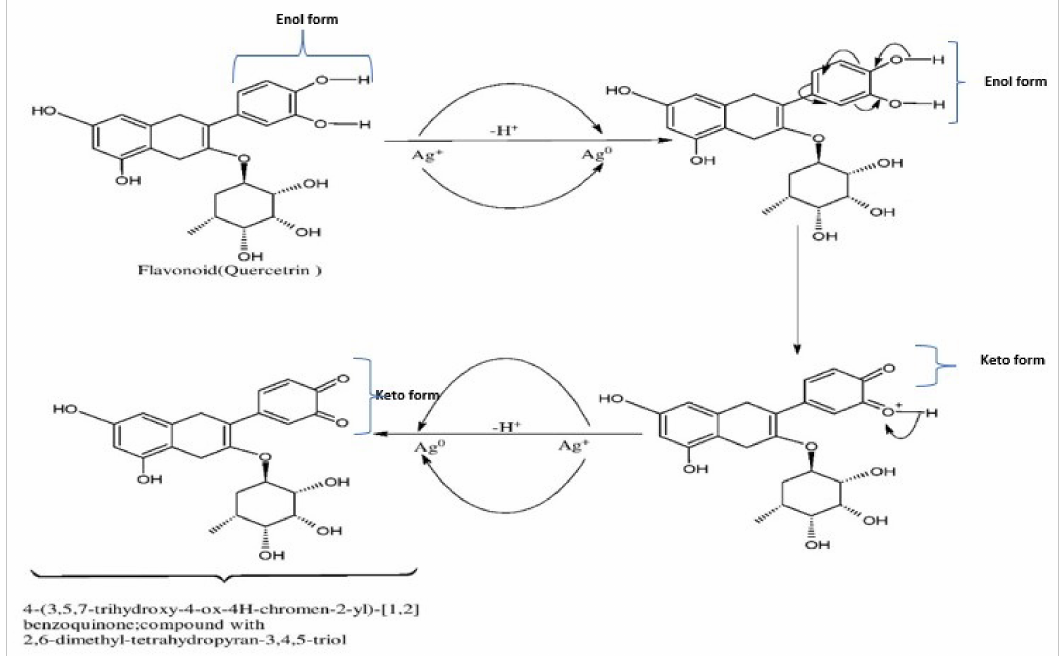
Figure 8. Biosynthesis mechanism of the AgNPs through involvement of the flavonoid (Quercitrin) present in